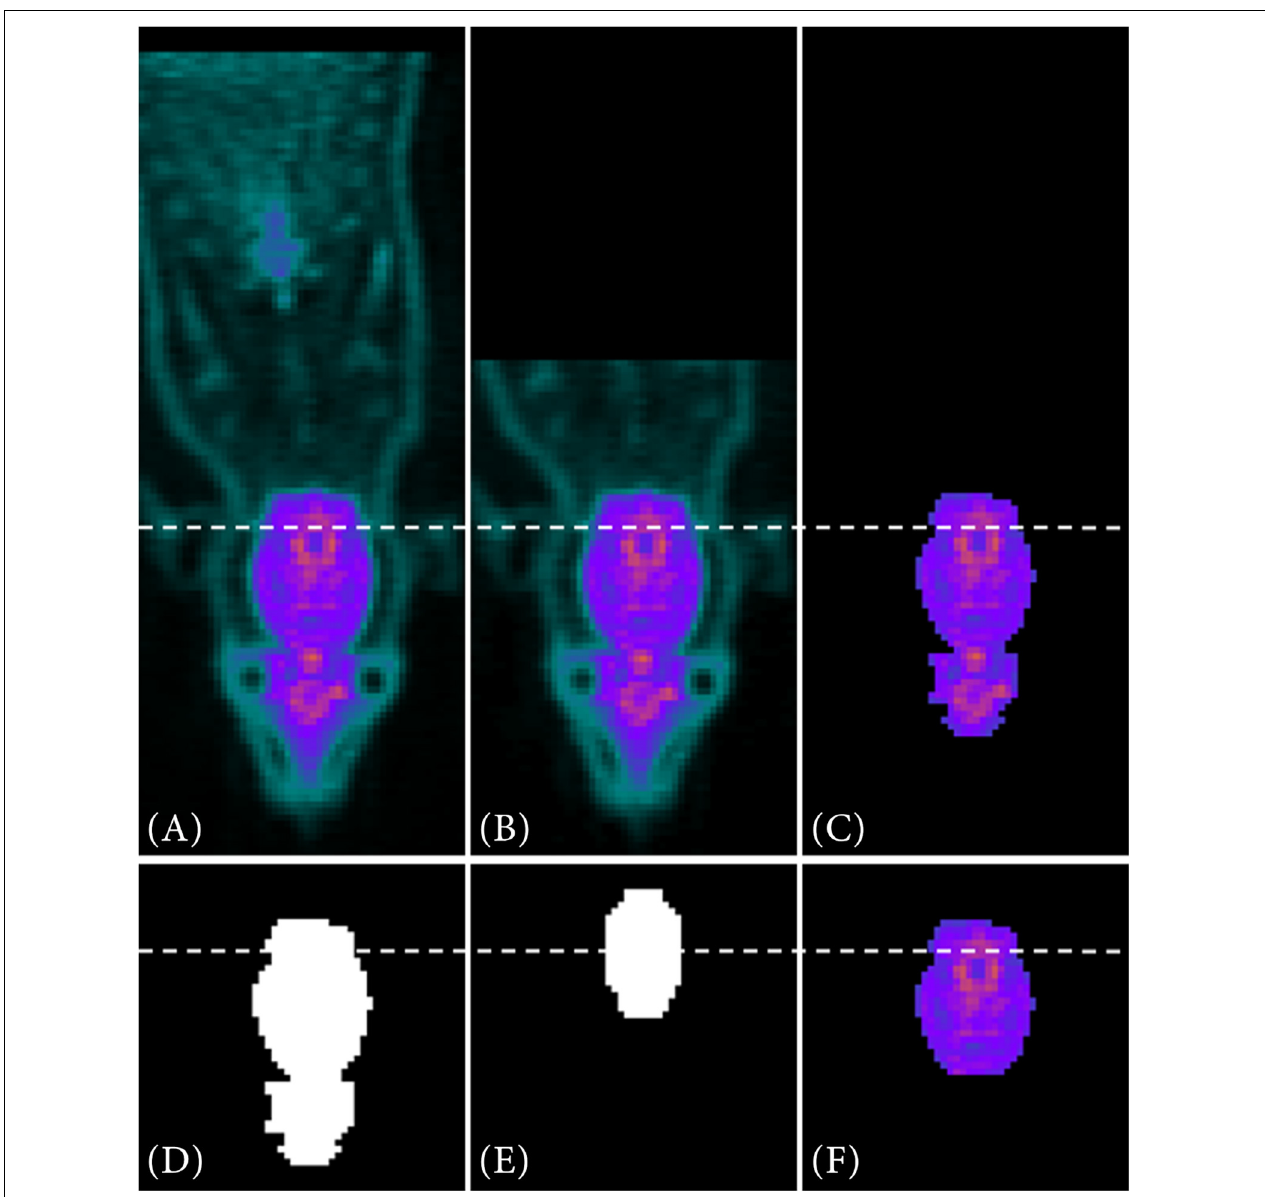
FIGURE 3 | VOI segmentation steps for a metabolic radiotracer. In (A) the full PET image is depicted. After data reduction (B) and automatically threshold adaption using the Otsu method (C) a binary image is created out of the reduced data (D) . Via contour matching with the resized MRI atlas set as a binary image (E) , the VOI is segmented (F)